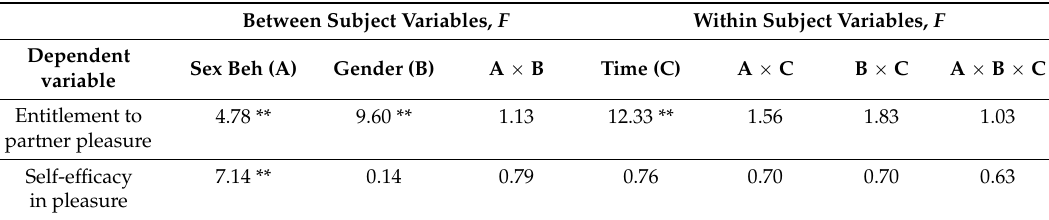
Table 4. Comparisons of entitlement to sexual partner pleasure and self-efficacy in achieving pleasure from T1 to T2 by sexual behavior group and gender ( N = 295).